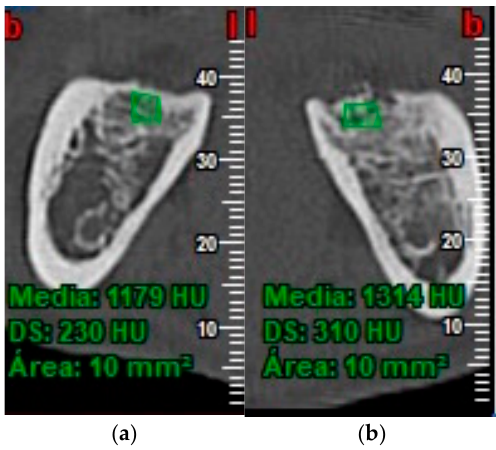
Figure 7. Bone density in control group ( a ) and test group ( b ).